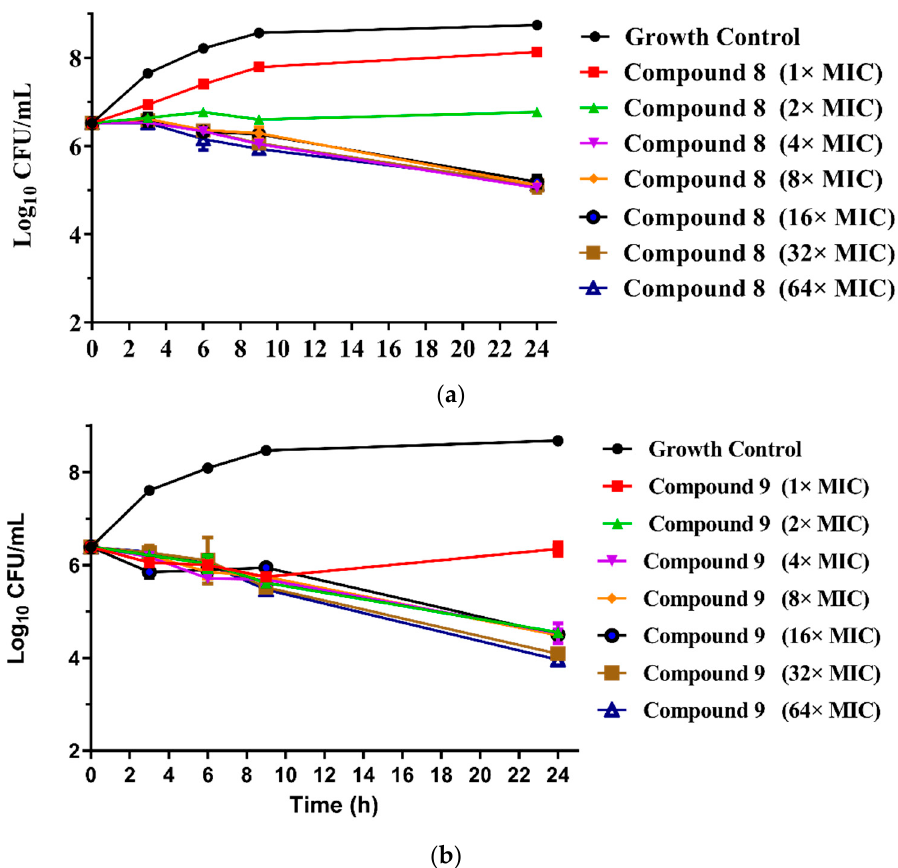
Figure 2. ( a ) Time-kill curves for MRSA ATCC 43300 with different concentrations of compounds 8 ; ( b ) time-kill curves for MRSA ATCC 43300 with different concentrations of compounds 9 .